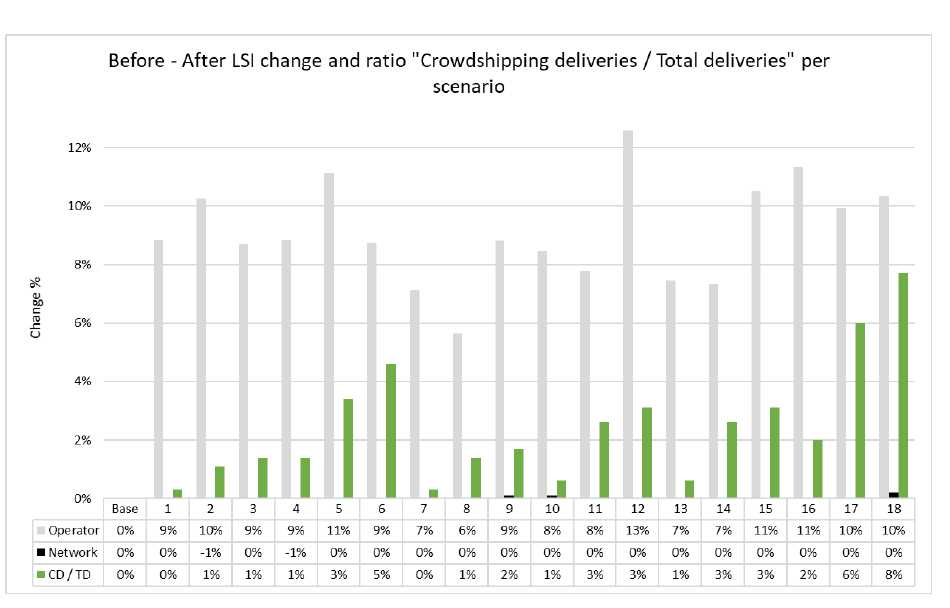
Figure 5. Before — After LSI change and CD/TD ratio per scenario. Figure 5. Before—After LSI change and CD/TD ratio per